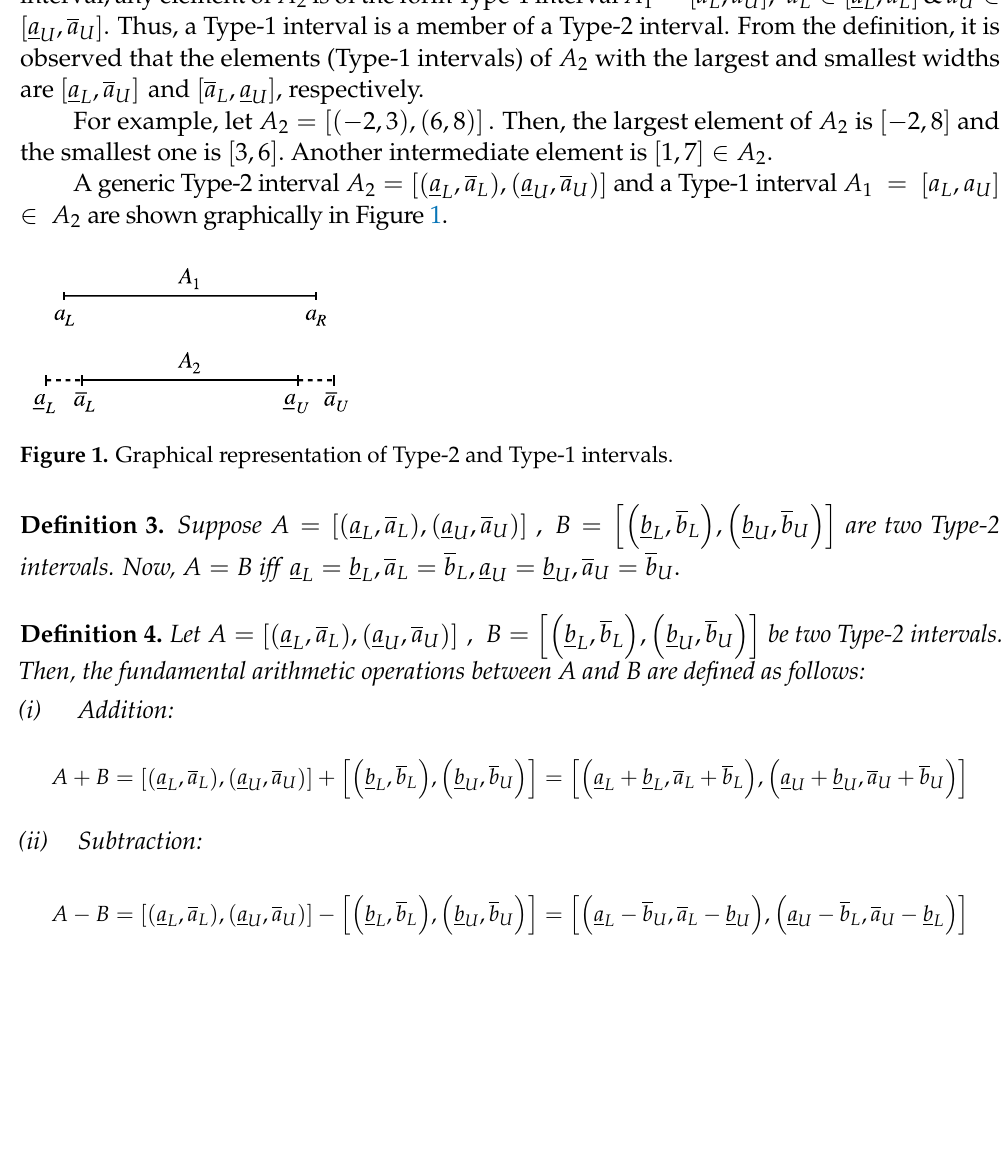
B 3. Type-2 Interval Order Relation In this section, the order relation of two Type-2 intervals is defined and, to justify its validity, two numerical examples are considered.